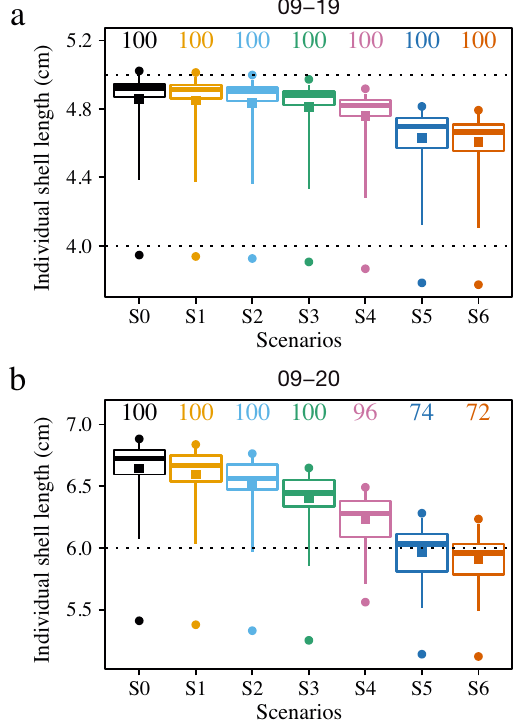
Fig. 6. Variability of individual shell length among farms on (a) September 1, 2019 and (b) September 1, 2020. Squares represent the mean, circles represent minimum and maxi- mum values, thick horizontal lines within boxes represent median values, bottom and top of boxes represent 25 and 75% percentiles and whiskers represent 2.5 and 97.5% per- centiles. The number of operable sites are shown at the top of the boxplots. Horizontal dotted lines represent target com- mercial sizes for feed production or human consumption, set at 4−5 and 6 cm, respectively